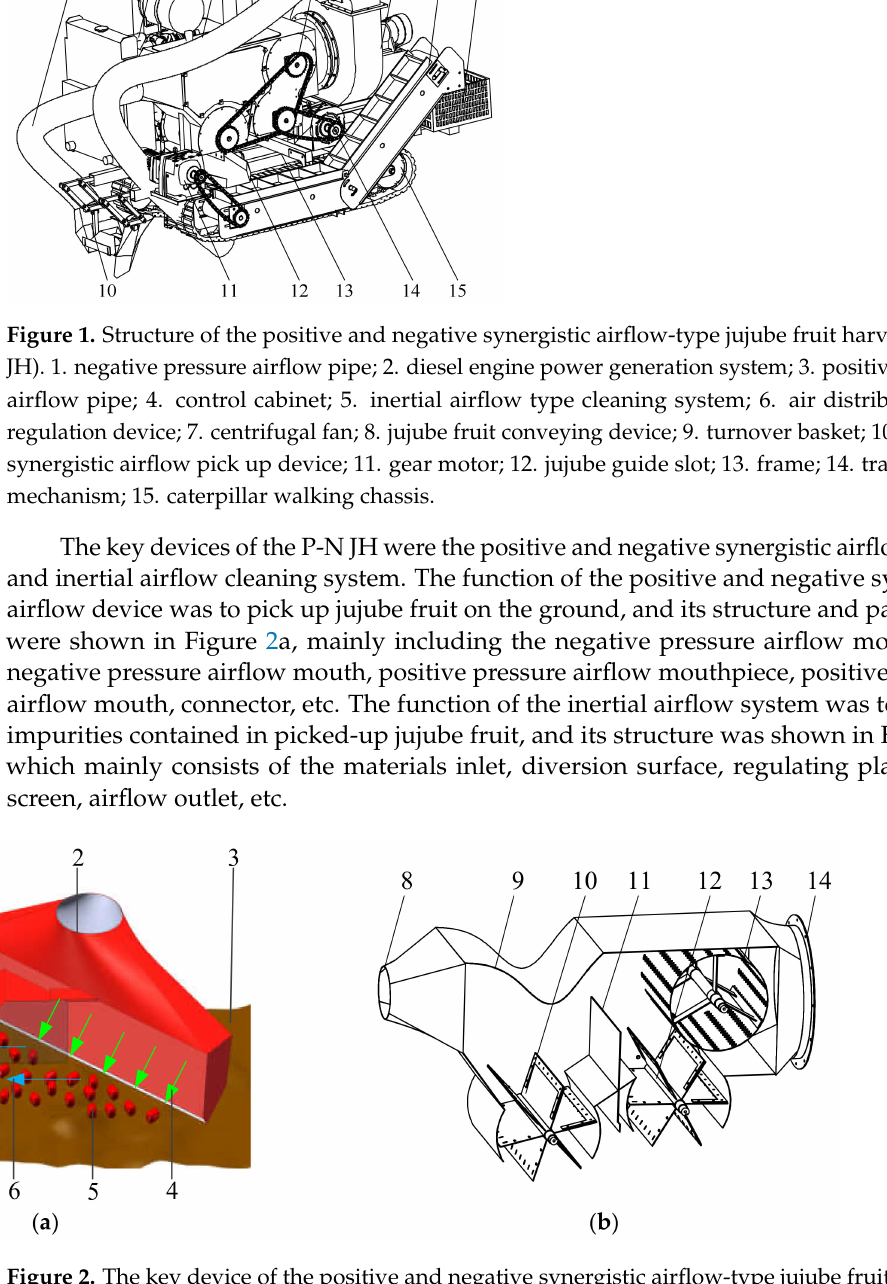
Figure 2. The key device of the positive and negative synergistic airflow-type jujube fruit harvester (P-N JH): ( a ) working principle of pneumatic pickup, and ( b ) operation principle diagram of the inertial airflow cleaning system. 1. negative pressure airflow mouthpiece; 2. positive pressure mouth; 3. ground; 4. positive pressure airflow direction; 5. jujube fruit; 6. jujube fruit movement direction;